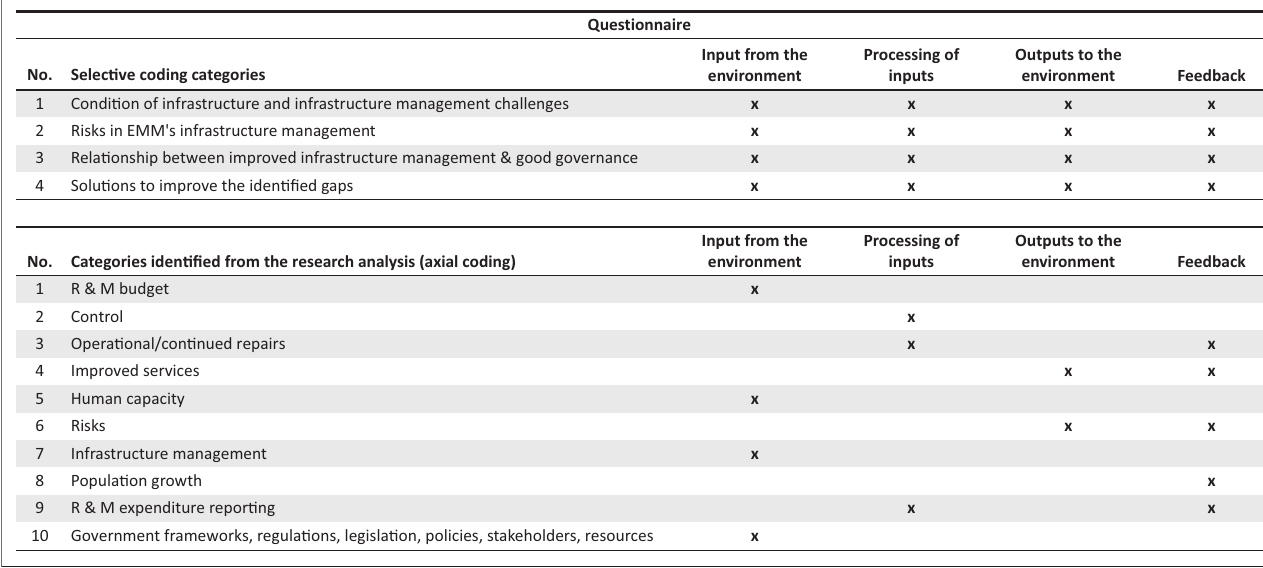
FIGURE 1: Schematic presentation of triangulated responses (selective and axial coding) to the interview